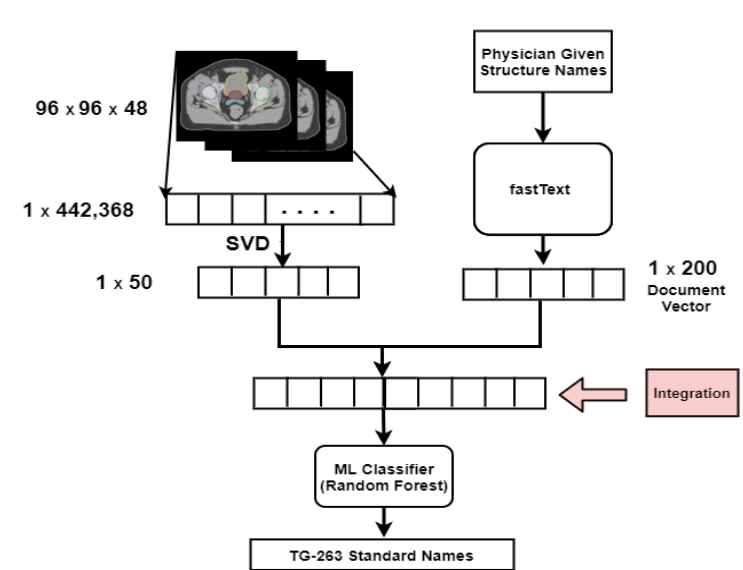
Figure 1. Intermediate integration method architecture for structure name